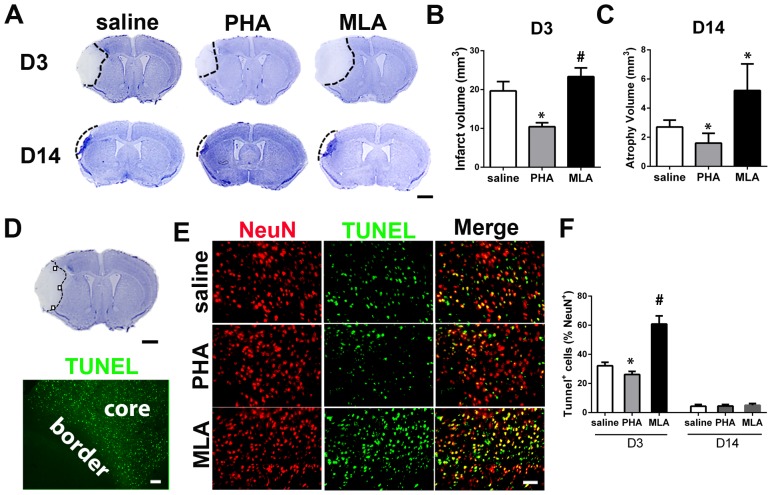
PHA reduced lesion volume and TUNEL+ neurons.A: Representative images of cresyl violet-stained sections on D3 and D14 after pMCAO. Scale bar: 1 mm. B: Quantification of infarct volume on D3. *: p = 0.009, #: p = 0.001 vs. saline group. C: Quantification of atrophy volume on D14 after pMCAO. *: p = 0.008 vs. corresponding saline groups. D: A cresyl violet-stained coronal section (bregma 1.3 mm, top, scale bar: 1 mm) and a TUNEL-stained section (bottom, scale bar: 50 um). Black squares in the cresyl violet-stained section show the areas used for quantification of NeuN+/TUNEL+ cells. Infarct border is shown in the TUNEL-stained section. E: Representative images of NeuN and TUNEL-stained sections. F: Quantification of NeuN and TUNEL double positive cells. *: p = 0.001, #: p<0.001 vs. saline group.